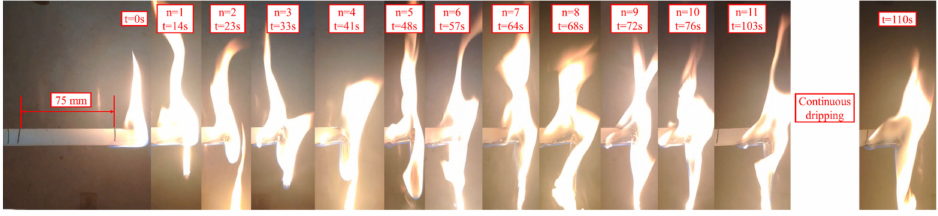
Figure 11. The combustion process of PP sample during UL-94 horizontal burning test.